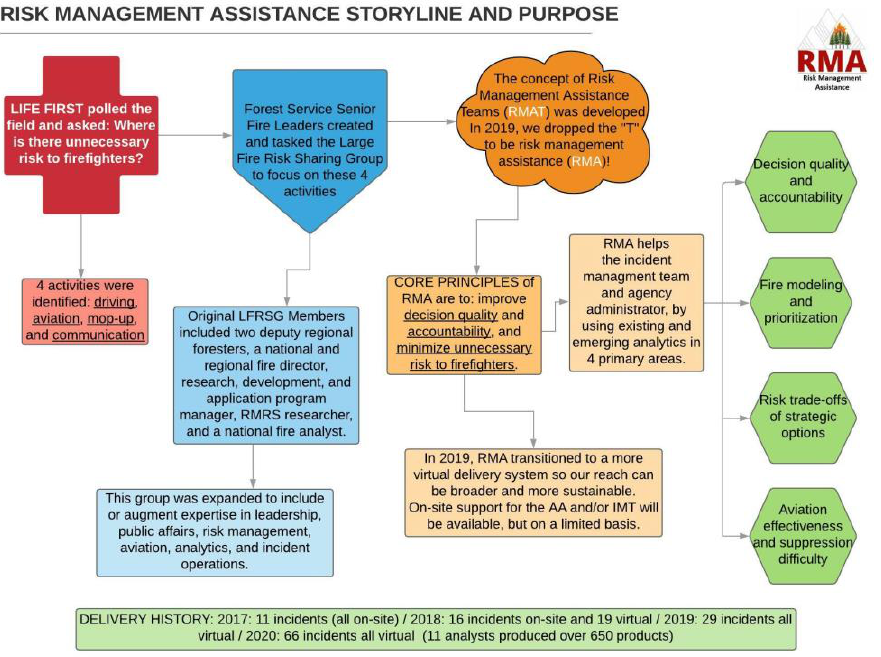
Figure 1. The risk management assistance (RMA) storyline and delivery history.